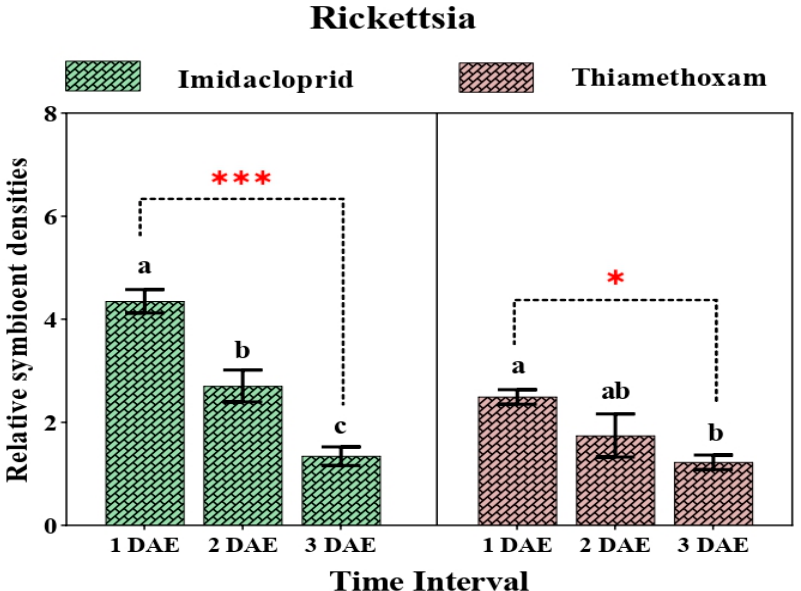
Figure 6. Relative density of Rickettsia in whiteflies after exposure to sublethal doses of imidacloprid 17.8 SL and thiamethoxam 25 WG at various durations (1 DAE, 2 DAE, and 3 DAE). Bars represent the standard error of the mean (SEM), and the different letters indicate statistically significant differences between the treatments. p ≤ 0.05 is indicated by * and p ≤ 0.001 is indicated by ***. DAE, days after exposure.